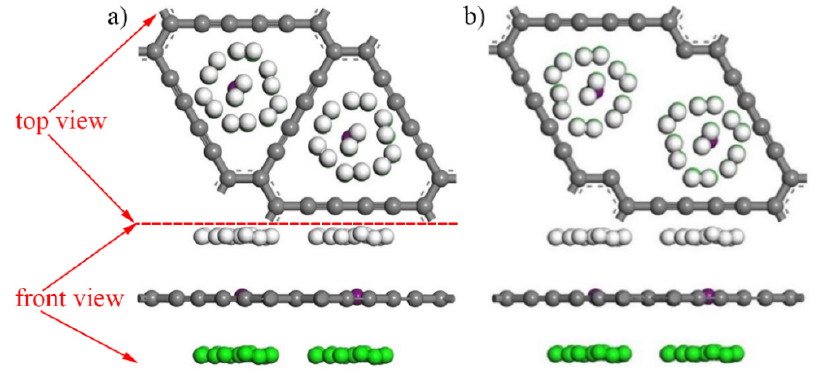
Figure 10. Maximum hydrogen storage capacity model of intrinsic γ -GDY and γ -VGDY. ( a ) Li 2 H 56 - GDY model, ( b ) Li 2 H 56 -VGDY model. (Hydrogen molecules on top and bottom surface are repre- sented by white and green balls, the purple balls represent Li atoms).